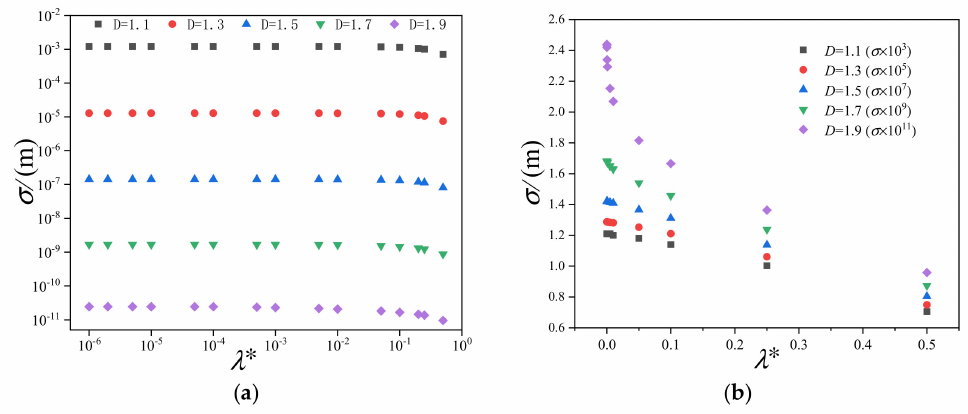
Figure 2. Thecalculatedstandarddeviation σ oftheideal subplaneheightwithvariousfractal